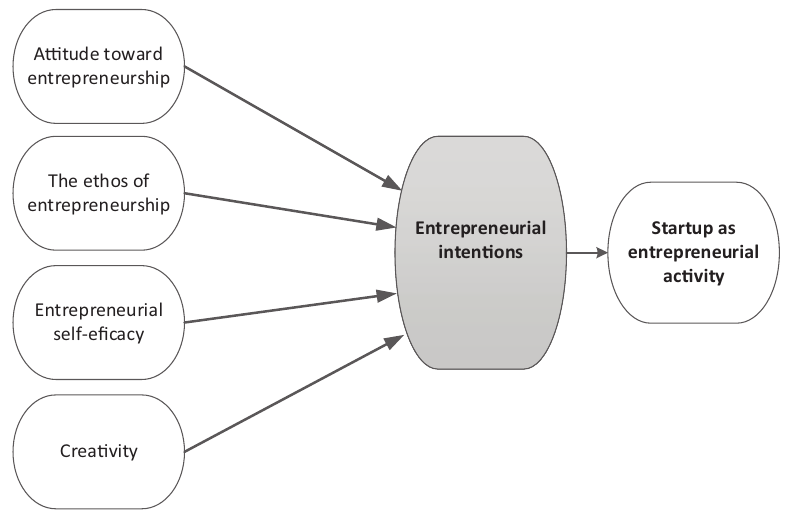
Figure 2. Conceptual model for hypotheses testing (source: created by